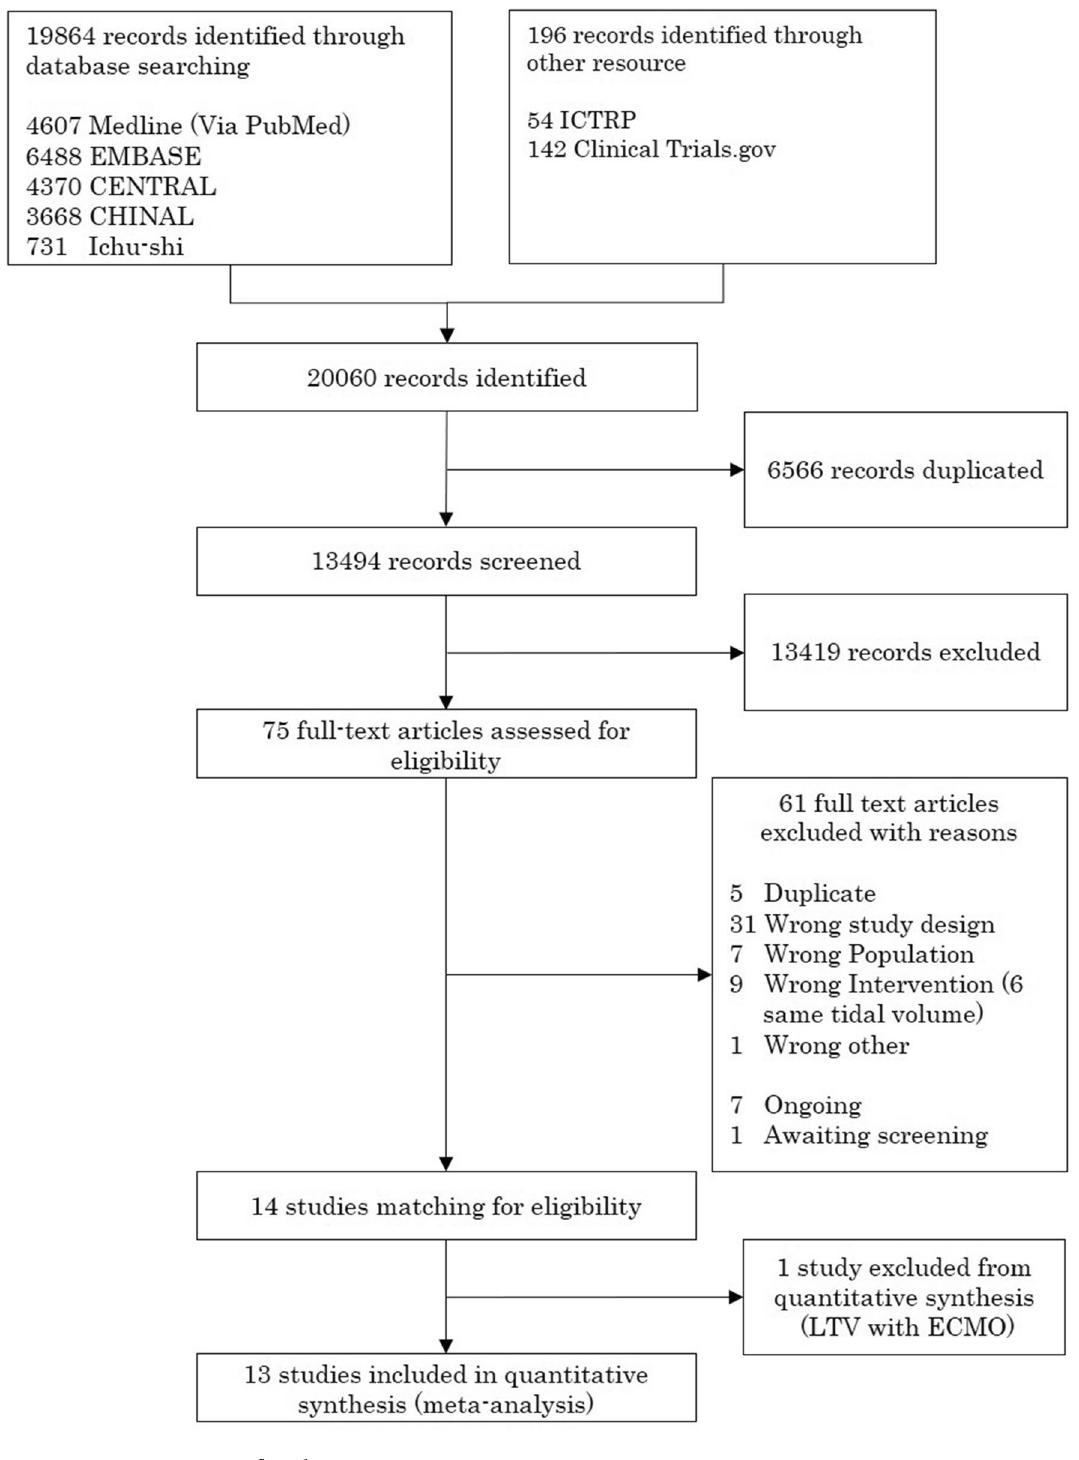
Figure 1. PRISMA flow